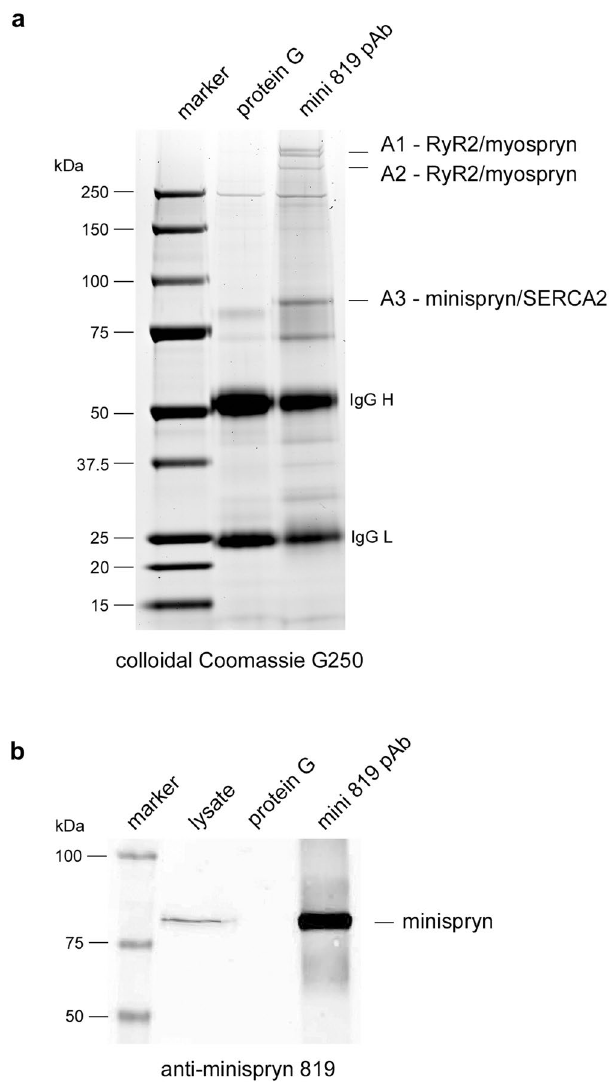
Figure 3. Immunoaffinity purification of the myospryn complex from cardiac muscle. ( a ) Proteins eluted from an anti-minispryn immunoaffinity column or protein G only column were separated by PAGE and stained with colloidal Coomassie blue dye. Bands A1-A3 that were only present in minispryn immunoaffinity eluate were excised and processed for mass spectrometry. The identity of the major protein(s) found in each band is listed. Note that in this study we focussed exclusively on proteins in bands A1, A2 and A3. Corresponding peptides for myospryn, RyR2 and minispryn are shown in Supplementary Dataset 1. ( b ) Robust minispryn enrichment following immunoaffinity purification was demonstrated by immunoblotting using the 819 anti-minispryn antibody. The sizes of the molecular weight markers are shown in